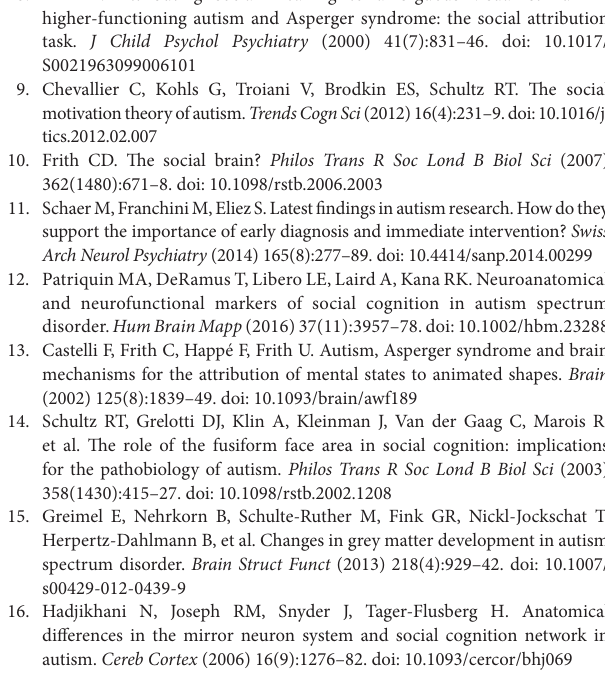
SUPPLEMENTARY FIGURE 1 | Source localisation of group differences for Group Map 3 showing increased activation of the left inferior parietal lobule (IPL) in the control-similar (CS) autism spectrum disorder (ASD) group (n = 8) compared to the typically developing (TD) group (n = 14) during free viewing of “Trotro” cartoons. The t-values of the unpaired t-test thresholded to P < 0.01 of the randomization test are plotted. L, Left; R, Right. SUPPLEMENTARY FIGURE 2 | Source localisation of group differences for Group Map 4 showing increased activation of the left posterior cerebellum (pCrbl), left inferior parietal lobule (IPL), and left superior and middle frontal gyri (SFG/MFG) in the control-similar (CS) autism spectrum disorder (ASD) group (n = 8) compared to the typically developing (TD) group (n = 14) during free viewing of “Trotro” cartoons. The t-values of the unpaired t-test thresholded to P < 0.01 of the randomization test are plotted. L, Left; R, Right. SUPPLEMENTARY FIGURE 3 | Source localisation of group differences for Group Map 3 showing decreased activation of the left middle frontal gyrus (MFG) and right superior frontal gyrus (SFG), and increased activation of right inferior temporal gyrus (ITG), middle temporal gyrus (MTG), fusiform gyrus (FG), precentral gyrus (PCG), and left inferior parietal lobule (IPL) in the control- dissimilar (CD) autism spectrum disorder (ASD) group (n = 6) compared to the typically developing (TD) group (n = 14) during free viewing of “Trotro” cartoons. The t-values of the unpaired t-test thresholded to P < 0.01 of the randomization test are plotted. L, Left; R, Right. SUPPLEMENTARY FIGURE 4 | Source localisation of group differences for Group Map 4 showing decreased activation of the left medial frontal gyrus (MedFG)/anterior cingulate gyrus (ACG), left superior frontal gyrus (SFG) and right middle frontal gyrus (MFG), and increased activation of the left and right anterior (aCrbl) and posterior cerebellum (pCrbl), right middle temporal gyrus (MTG), right inferior temporal gyrus (ITG), left and right fusiform gyrus (FG), and left inferior parietal lobule (IPL) in the control-dissimilar (CD) autism spectrum disorder (ASD) group (n = 6) compared to the typically developing (TD) group (n = 14) during free viewing of “Trotro” cartoons. The t-values of the unpaired t-test thresholded to P < 0.01 of the randomization test are plotted. L, Left; R,